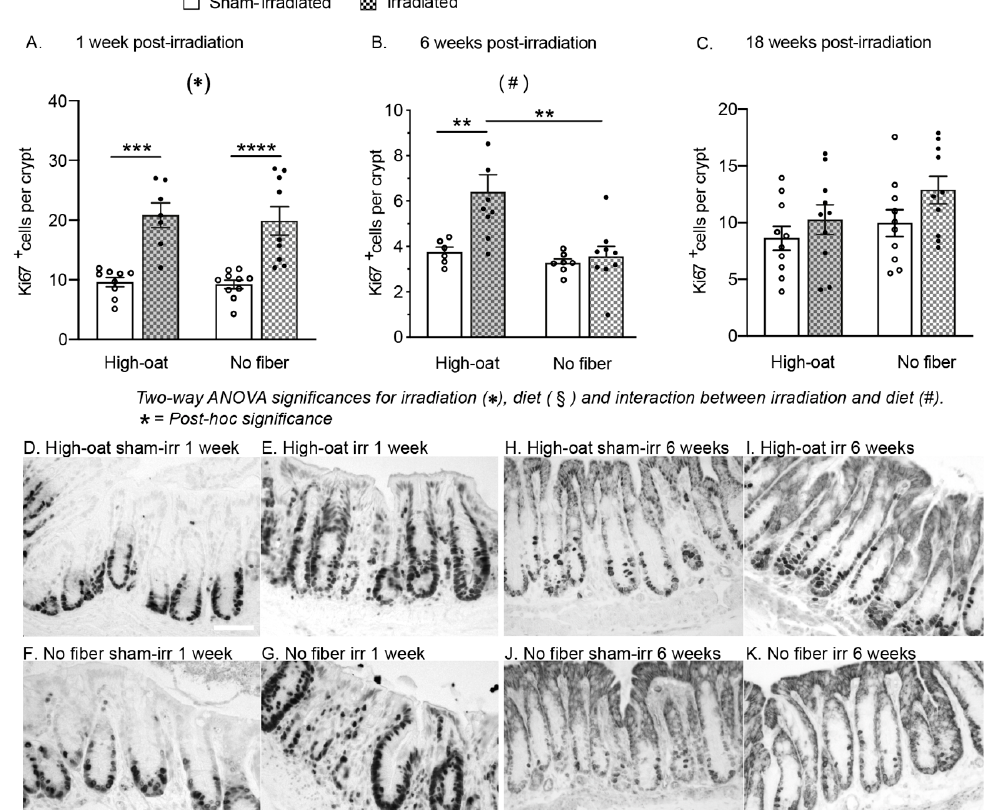
Figure 4. The average number of Ki67-positive proliferating cells per mucosal crypt in mice fed a fiber-rich or a fiber-free diet. ( A ). An irradiation-induced increase in the number of Ki67-positive cells was found in both the High-oat and No-fiber animals at one week after irradiation. *** p = 0.0002, **** p = 0.0001. ( B ). At six weeks, an increase in the Ki67-positive cells was still observed in the High-oat irradiated mice but not in the No-fiber mice. ** p = 0.0088, ** p = 0.0015. ( C ). At 18 weeks, there was a slight increase in crypt cell proliferation in both irradiated groups, although this was not statistically significant. ( D – K ). Micrographs (40× magnification) of proliferating cells visualized with immunohistochemistry using an antibody against Ki67 and a DAB stain. Scale bar 50 μ m. Data are shown as mean ± S.E.M.